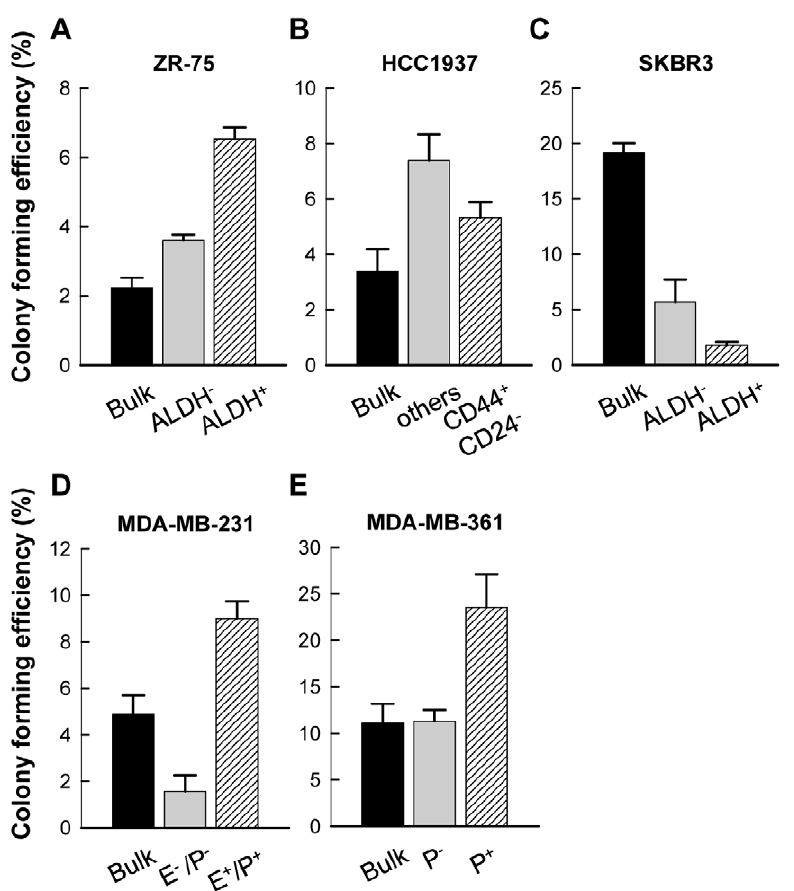
Figure 1. Soft agar colony forming efficiency of bulk cells or marker expressing or nonexpressing subpopulations from breast cancer cell lines. Soft agar colony formation assay of cells isolated from ZR-75 (A), HCC1937 (B), SKBR-3 (C), MDA-MB-231 (D) and MDA-MB361 (E) cells with the indicated cell surface markers expressed. The unsorted cells (Bulk) were used as control. Shown is the percentage of colony formation. Results are means 6 SD of triplicate samples from one representative experiment.